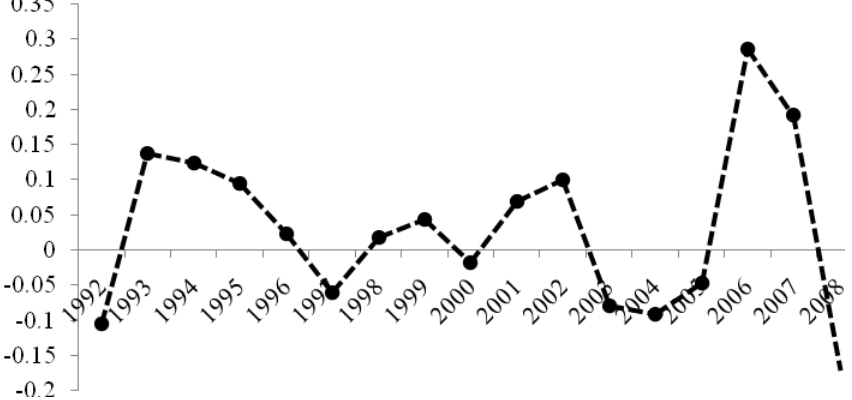
Figure 3 Annual growth rates of construction permits in urban areas (Source: Central Bank of